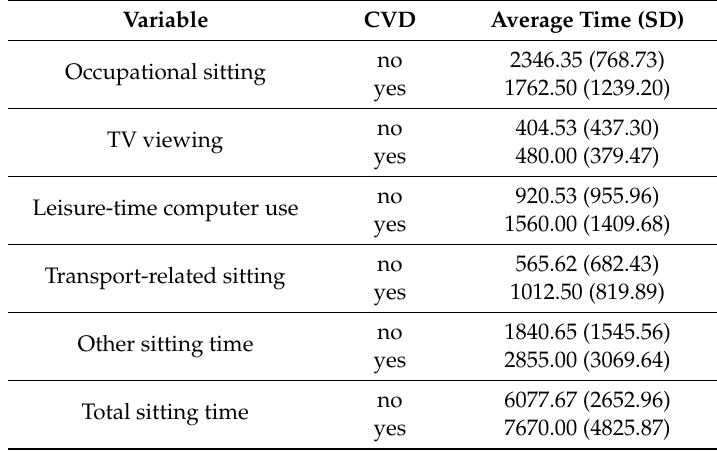
Table 2. Descriptive statistical summary of time spent on various sedentary behaviors.